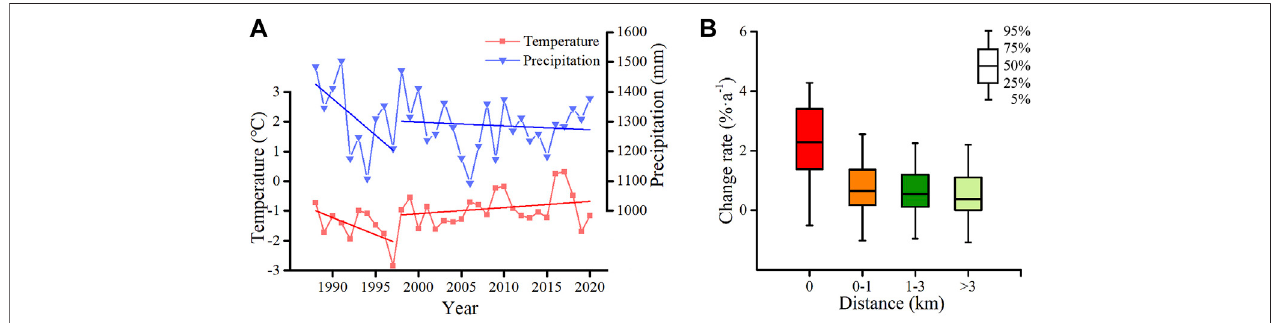
FIGURE10|(A) AnnualchangeintemperatureandprecipitationintheYZRBbetween1988and2020. (B) Relationshipbetweenthedistanceofaglaciallaketoits mother glacier and its change rate.